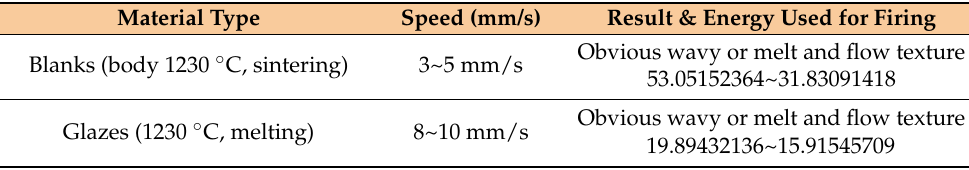
Table 1. Effect of laser speeds on ceramic